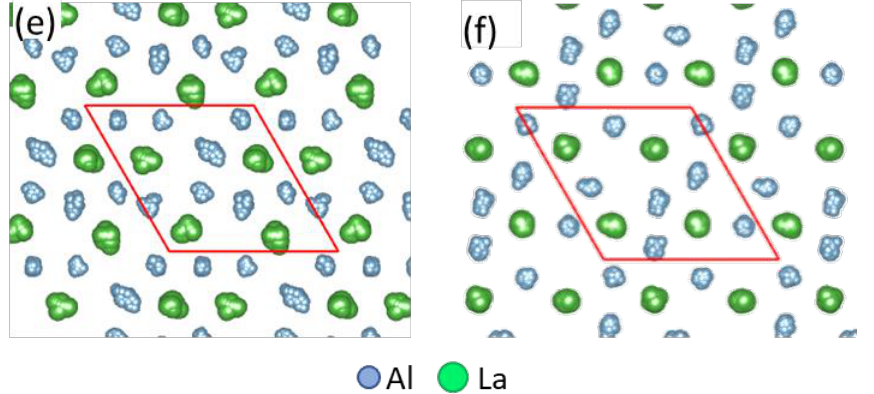
Figure 37. Ab initio molecular dynamics (AIMD) simulation of La segregation at L-Al/ γ -Al 2 O 3 interface [88]. ( a , b ) Snapshots of La segregation at ( a ) L-Al/ γ -Al 2 O 3 {1 1 1} AlM_1 and ( b ) L-Al/ γ -Al 2 O 3 {1 1 1} AlM_2 interfaces at equilibrium at 1000 K; ( c ) and ( d ) atomic density profiles ρ(z) of La segregated at the L- Al/γ -Al 2 O 3 {1 1 1} AlM interfaces where the black curve represents ρ(z) for all atoms, while the light-green curve is for La; and ( e ) and ( f ) top view of in-plane atomic arrangement of the La segregation layer at the L-Al/ γ -Al 2 O 3 {1 1 1} AlM interfaces. The blue spheres represent Al atoms, dark-brown O, and light-green La.